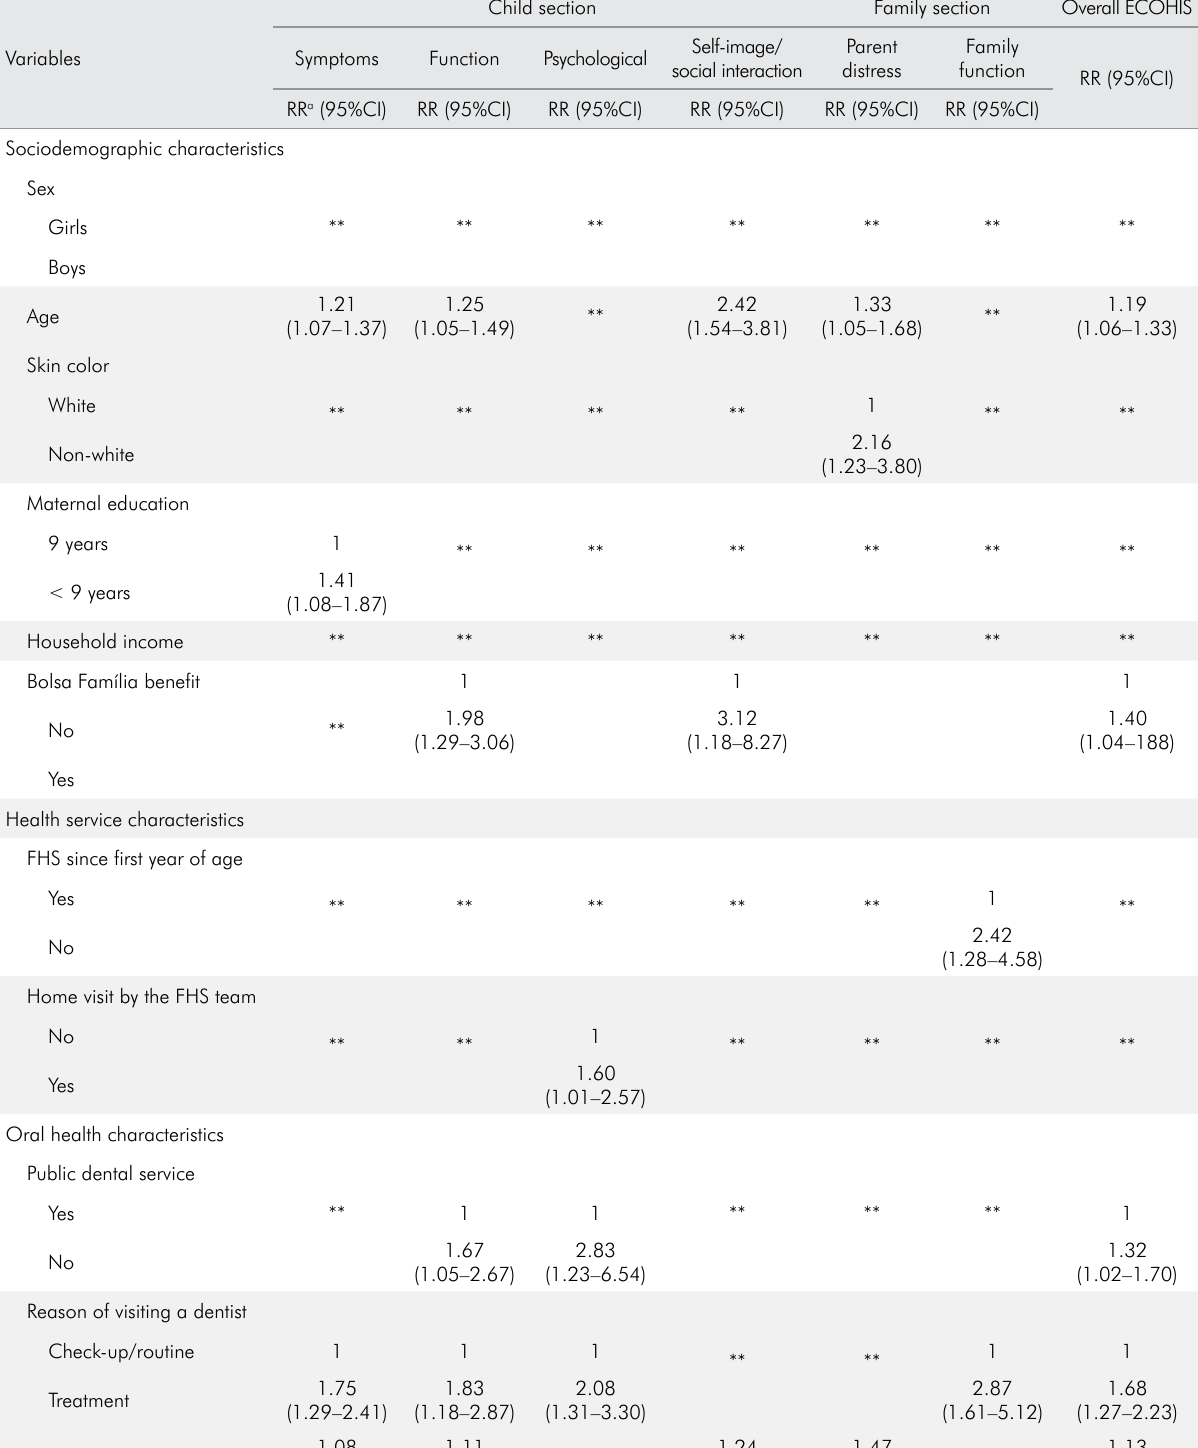
Table 4. Adjusted association between independent variables and overall and domain-specific ECOHIS scores at baseline (T1) and 2-year follow-up (T2), determined using multilevel Poisson